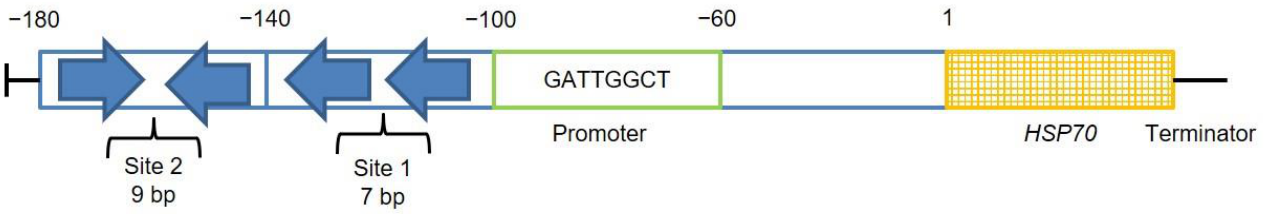
Figure 1. The structure of HSP genes. Abbreviations: HSP, heat shock protein.